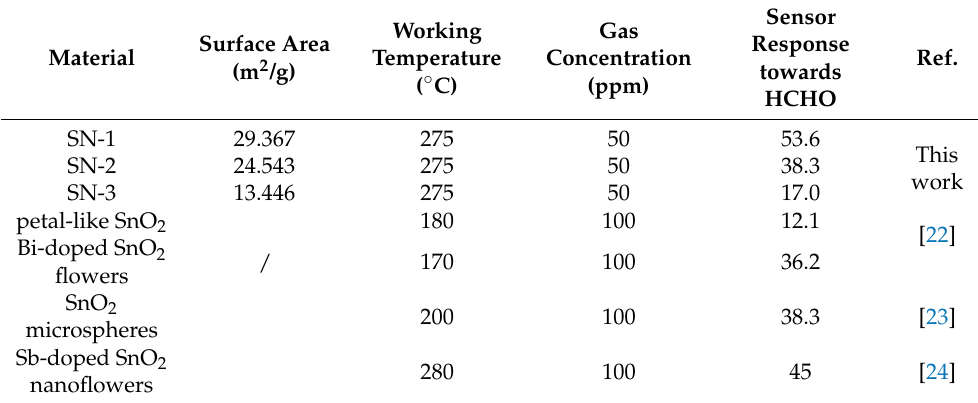
Table 1. Comparison of different SnO 2 structures in this study and other